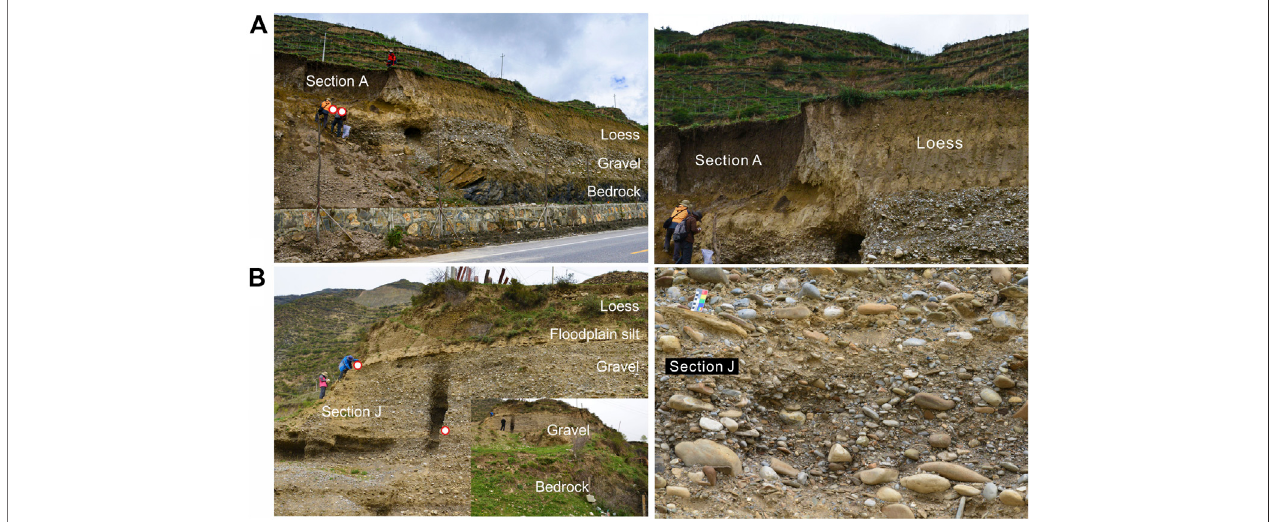
FIGURE 3 | Photographs showing Section A at site 1 (A) and Section J at site 3 (B) , which represent two terrace sections. Enlarged views of the loess deposits in Section A and gravel deposits in Section J on the right showing details of their sedimentary characteristics.